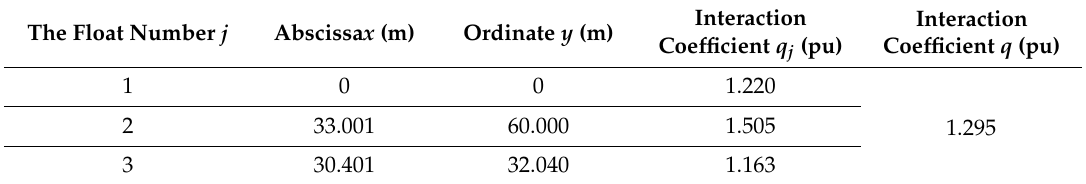
Table 5. Energy capture coefficient of the WEC array under the traditional DE algorithm ( N = 3). The Float Number j